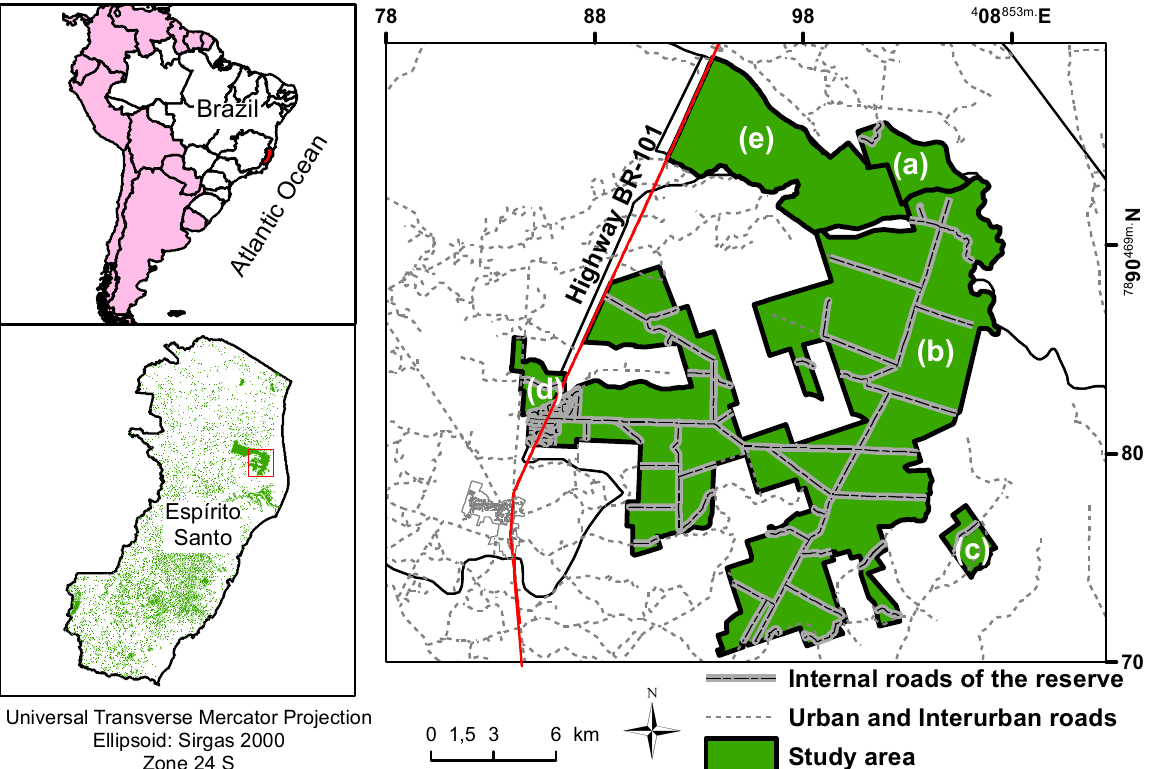
Figure. 1. Location of the area of study. The RNV consists of four matrices: (a) Jaguaré, (b) Linhares, (c) Imbiribas and (d) Rancho Alto. The surrounding area includes a small part of the REBIO of Sooretama (e), which is bordered by federal Highway BR-101, which traverses the study